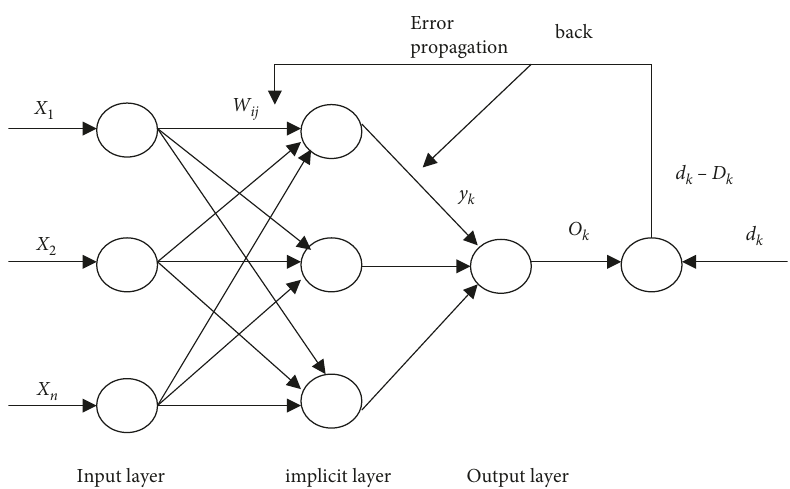
Figure 1: Evaluation model of BP neural